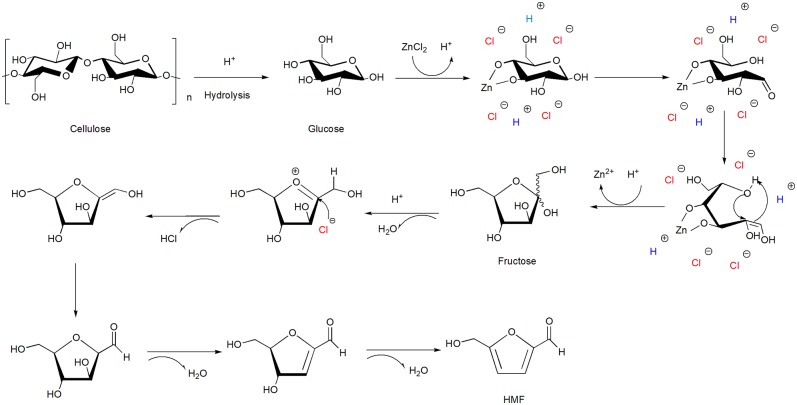
Schematic diagram of 5-hydroxymethylfurfural (HMF) formation from cellulose in the presence of ZnCl2.